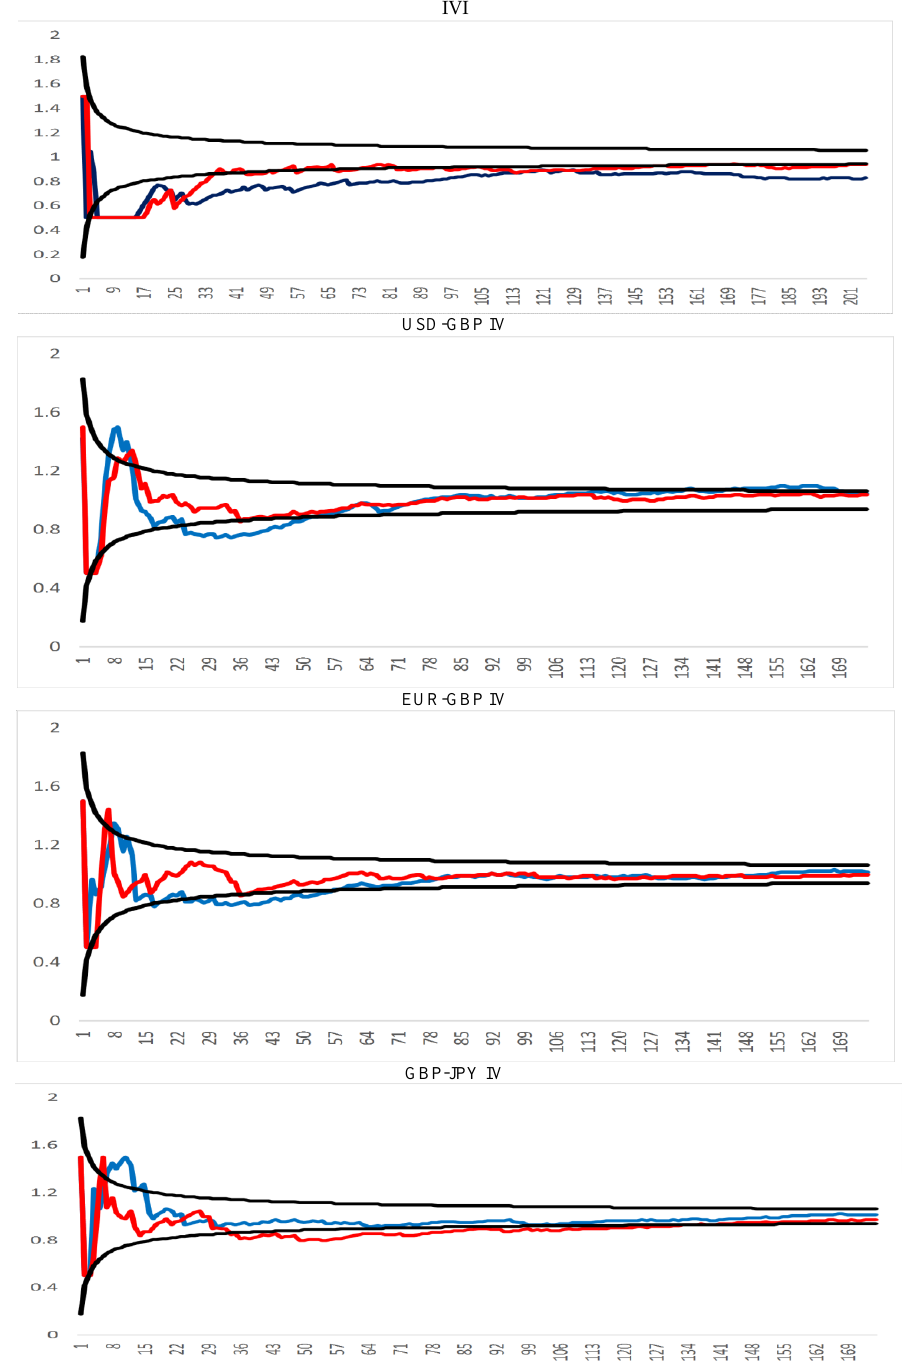
Figure 3. Estimates of d for each subsample using semi-parametric methods. The estimated d prior to the Brexit referendum is in blue, the one after the Brexit referendum is in red.